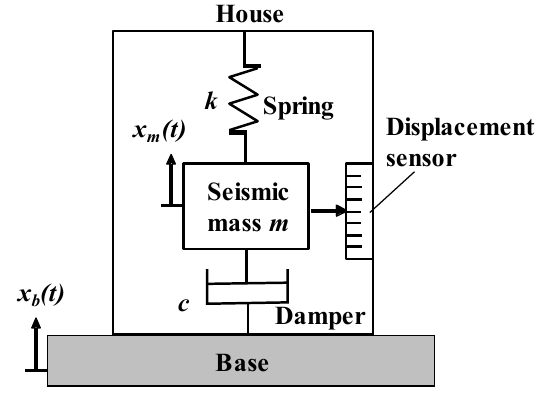
Figure 1. Typical accelerometer structure diagram.